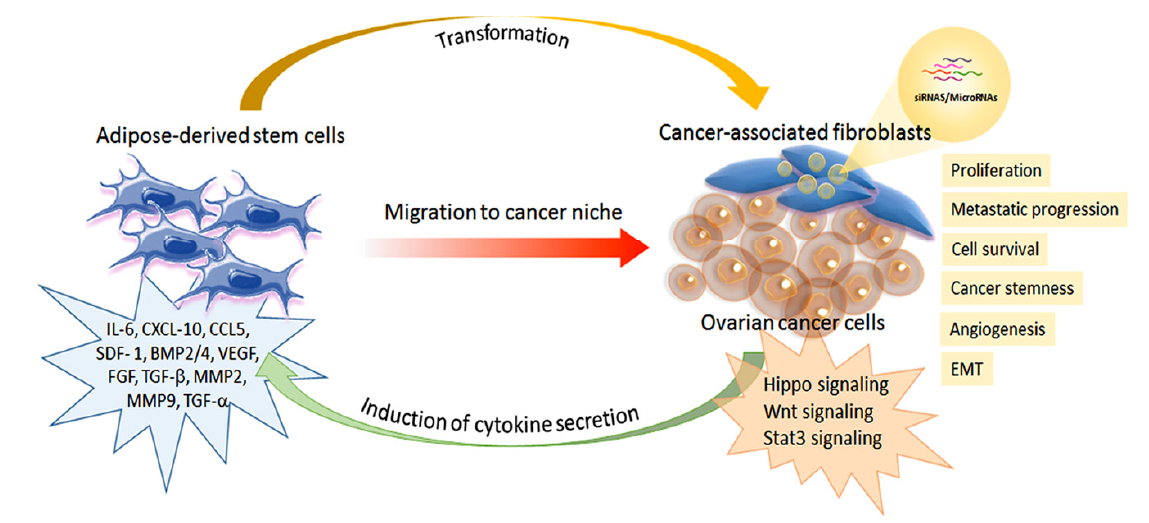
Figure 2. Schematic representation of the interplay between adipose-derived stem cells and ovarian cancer cells.